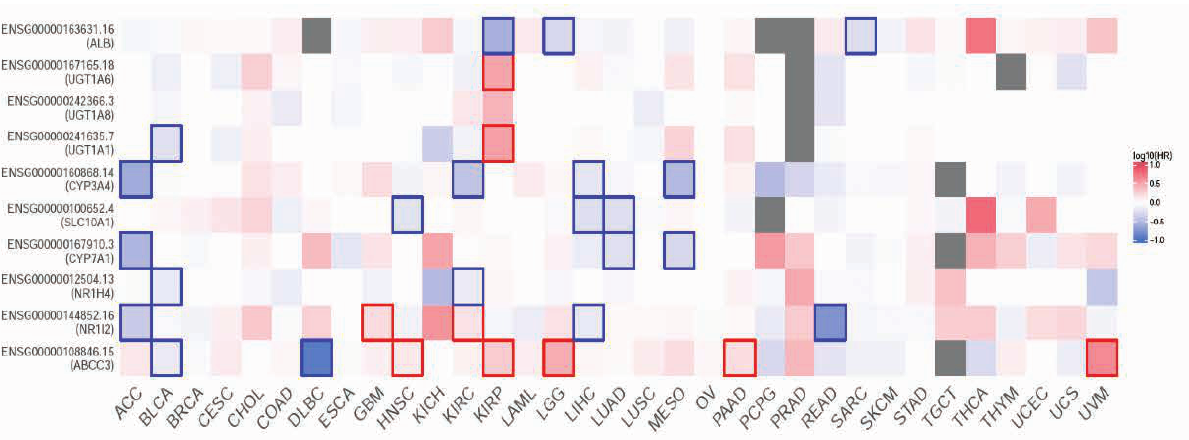
Figure 5: Survival curves of prognostic relationship between ABCC3 high and low expression group in glioma patients (A: comparison of overall survival of glioma patients; B: comparison of progression-free survival of glioma patients; C: comparison of overall survival of astro- cytoma; D: comparison of progression-free survival of astrocytoma; E: comparison of overall survival of oligoastrocytoma; F:comparison of progression-free survival of oligoastrocytoma; G: Total survival comparison of oligodendroglioma; G:progression-free survival comparison of oligodendroglioma)